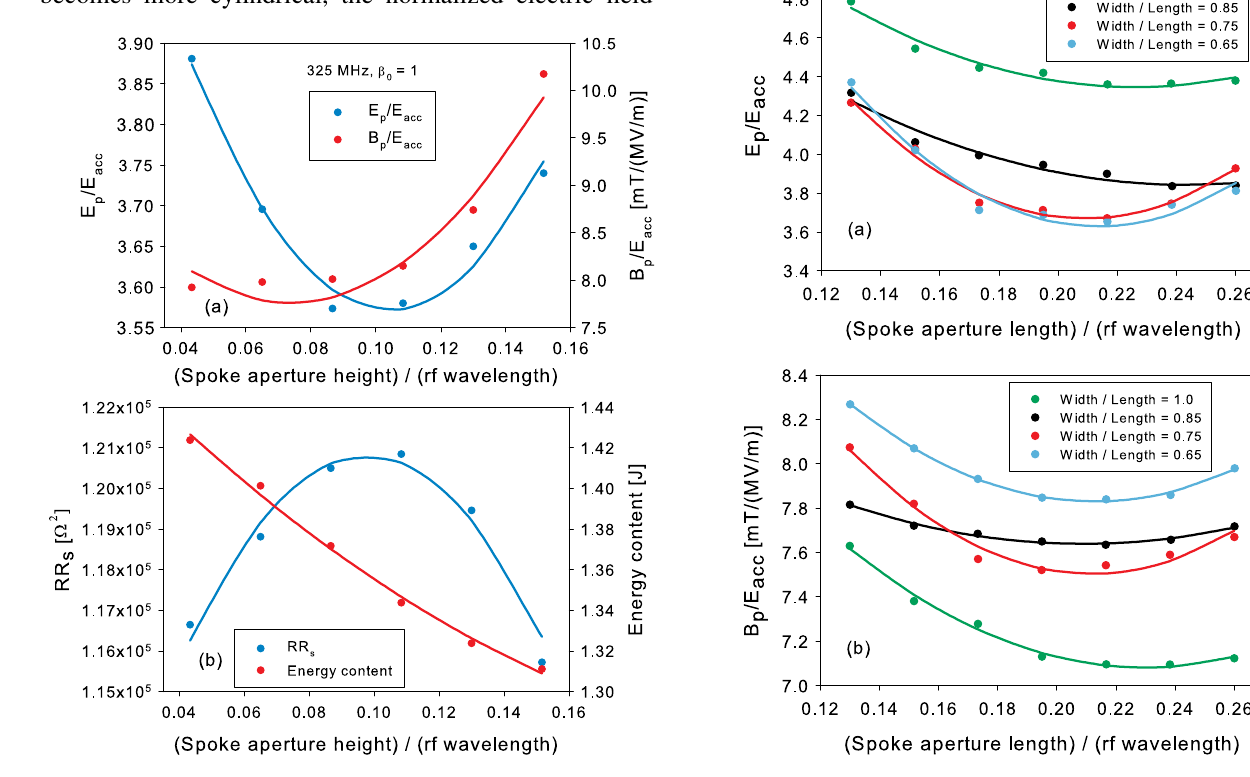
FIG. 19. Dependence of the (a) normalized electric and (b) magnetic fields on spoke aperture